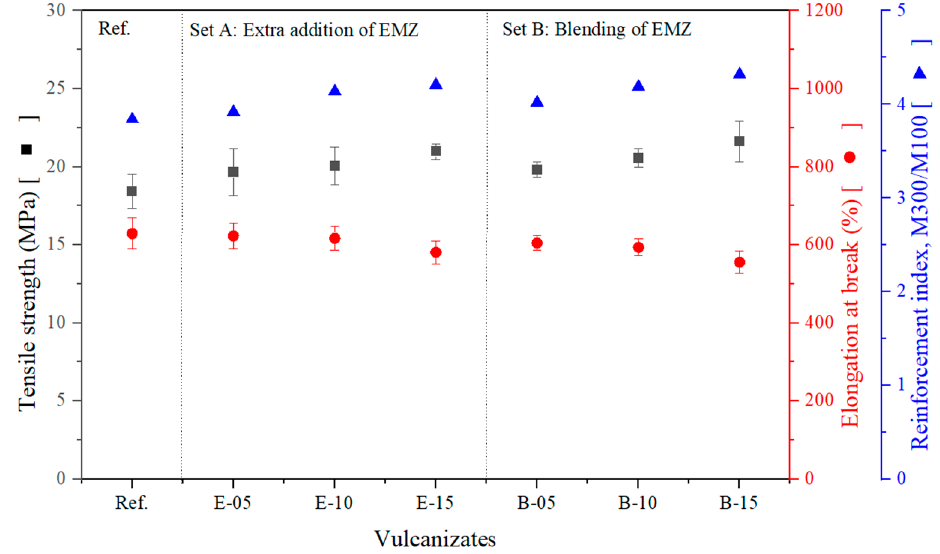
Figure 6. Effect of EMZ content on tensile strength, elongation at break, and reinforcement index of silica-filled NR vulcanizates. EMZ was added via either extra addition (Set A) or blending (Set B) .